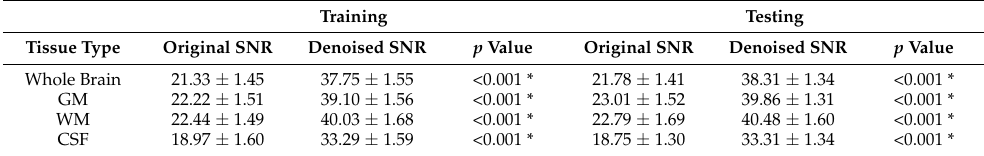
Table 1. SNR before and after the denoising model.